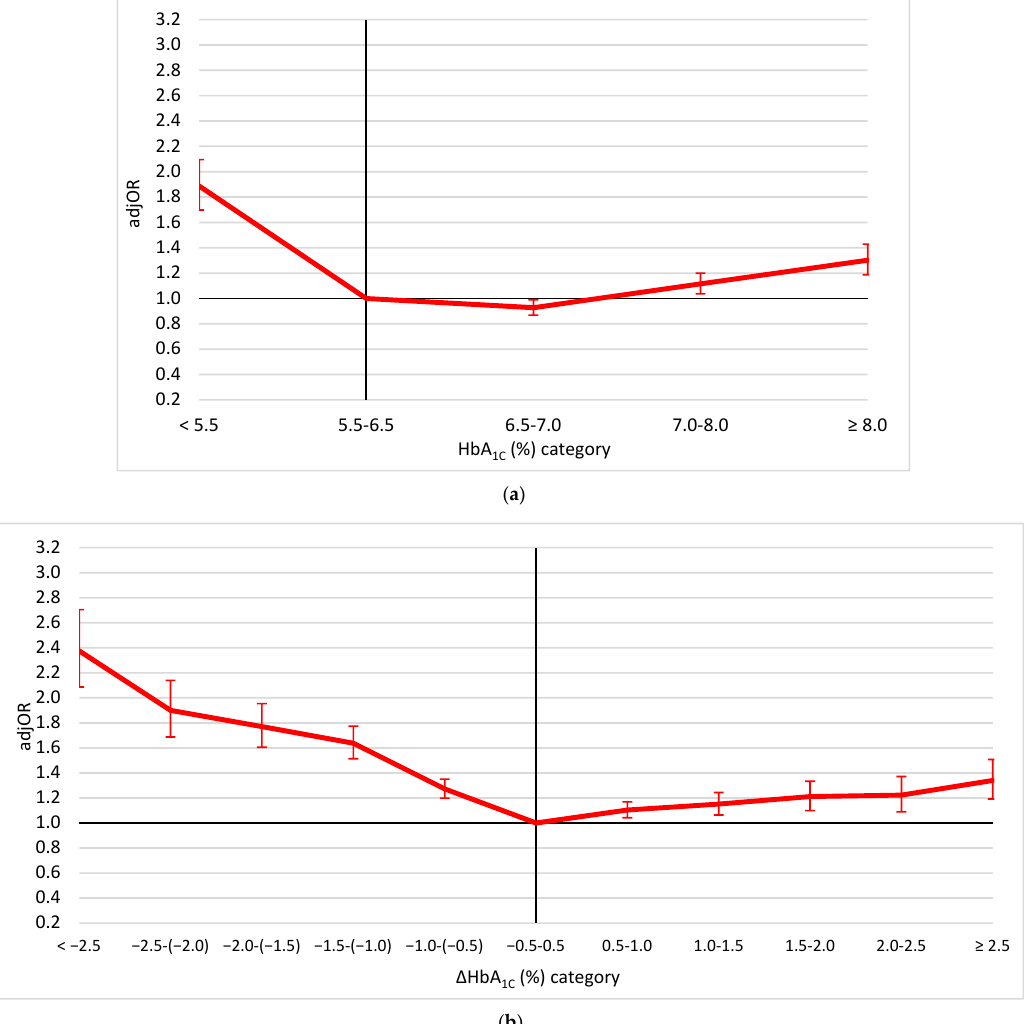
Figure 2. The associations (adjusted odds ratios and 95% confidence intervals): ( a ) Between HbA 1C and mortality; ( b ) Between HbA 1C change ( ∆ HbA 1C ) and mortality, adjusted for the potential confounders. The results of the combined model included HbA 1C levels and ∆ HbA 1C , adjusted for: repeated measures, time from hospital discharge, age, sex, supraventricular arrhythmias, congestive heart failure, chronic ischemic heart disease, history of myocardial infarction, history of percutaneous coronary intervention, history of a coronary artery bypass graft, atrioventricular block, renal failure, diabetes mellitus, hypertension, peripheral vascular disease, chronic obstructive pulmonary disease, neurological disorders, malignancy, anemia, gastrointestinal bleeding, alcohol/drug addiction, type of acute myocardial infarction, severe left ventricular dysfunction, left ventricular hypertrophy and three-vessel/left-main coronary arteries disease. Abbreviations: AdjOR—adjusted odds ratio, HbA 1C —hemoglobin A 1C , HbA 1C change ( ∆ HbA 1C )—the difference between two HbA 1C tests